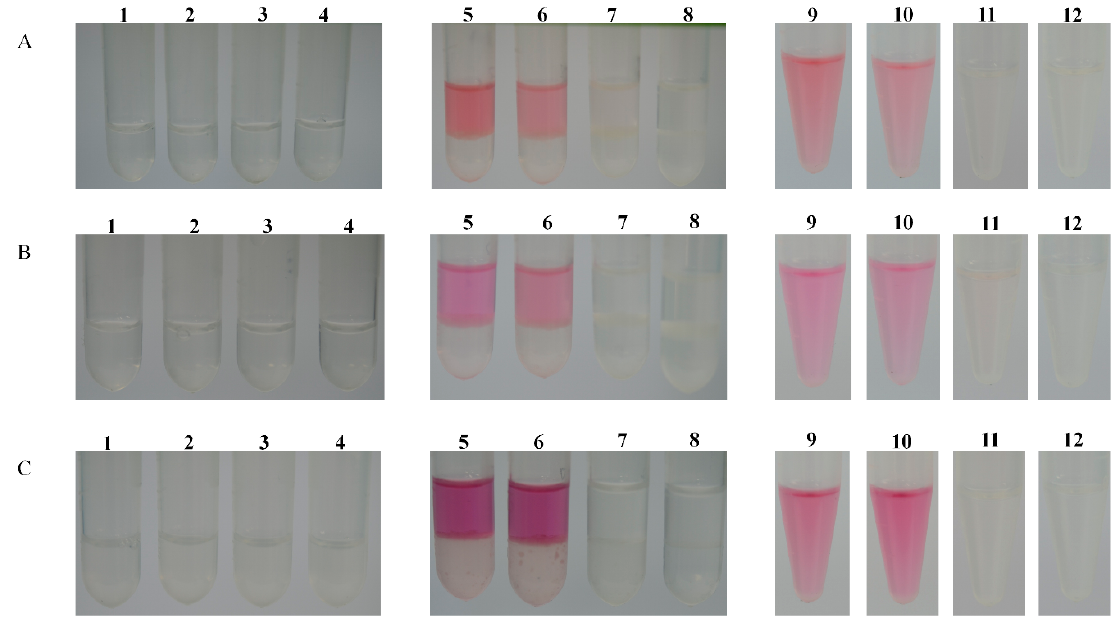
Figure 3. Enzyme assay of the MaDFRa, MaDFRb and MaDFRc proteins. ( A ). Enzymatic reaction process of the substrate DHK. 1, 2, 3 and 4; A 500 µL reaction mixture containing 70 µL (10 mM) Tris-